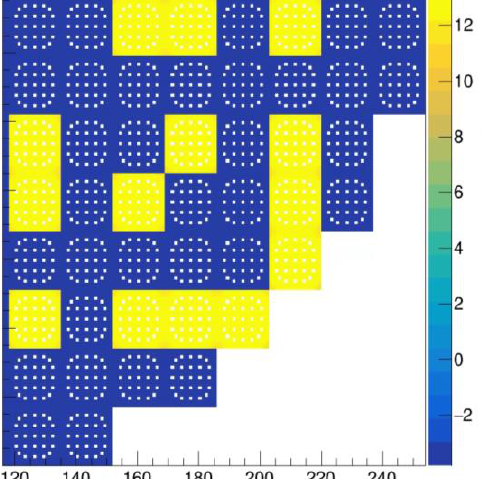
Figure 7. Neutron emission rate and fission rate distributions comparison ((neutrons – fission)/neutrons) from